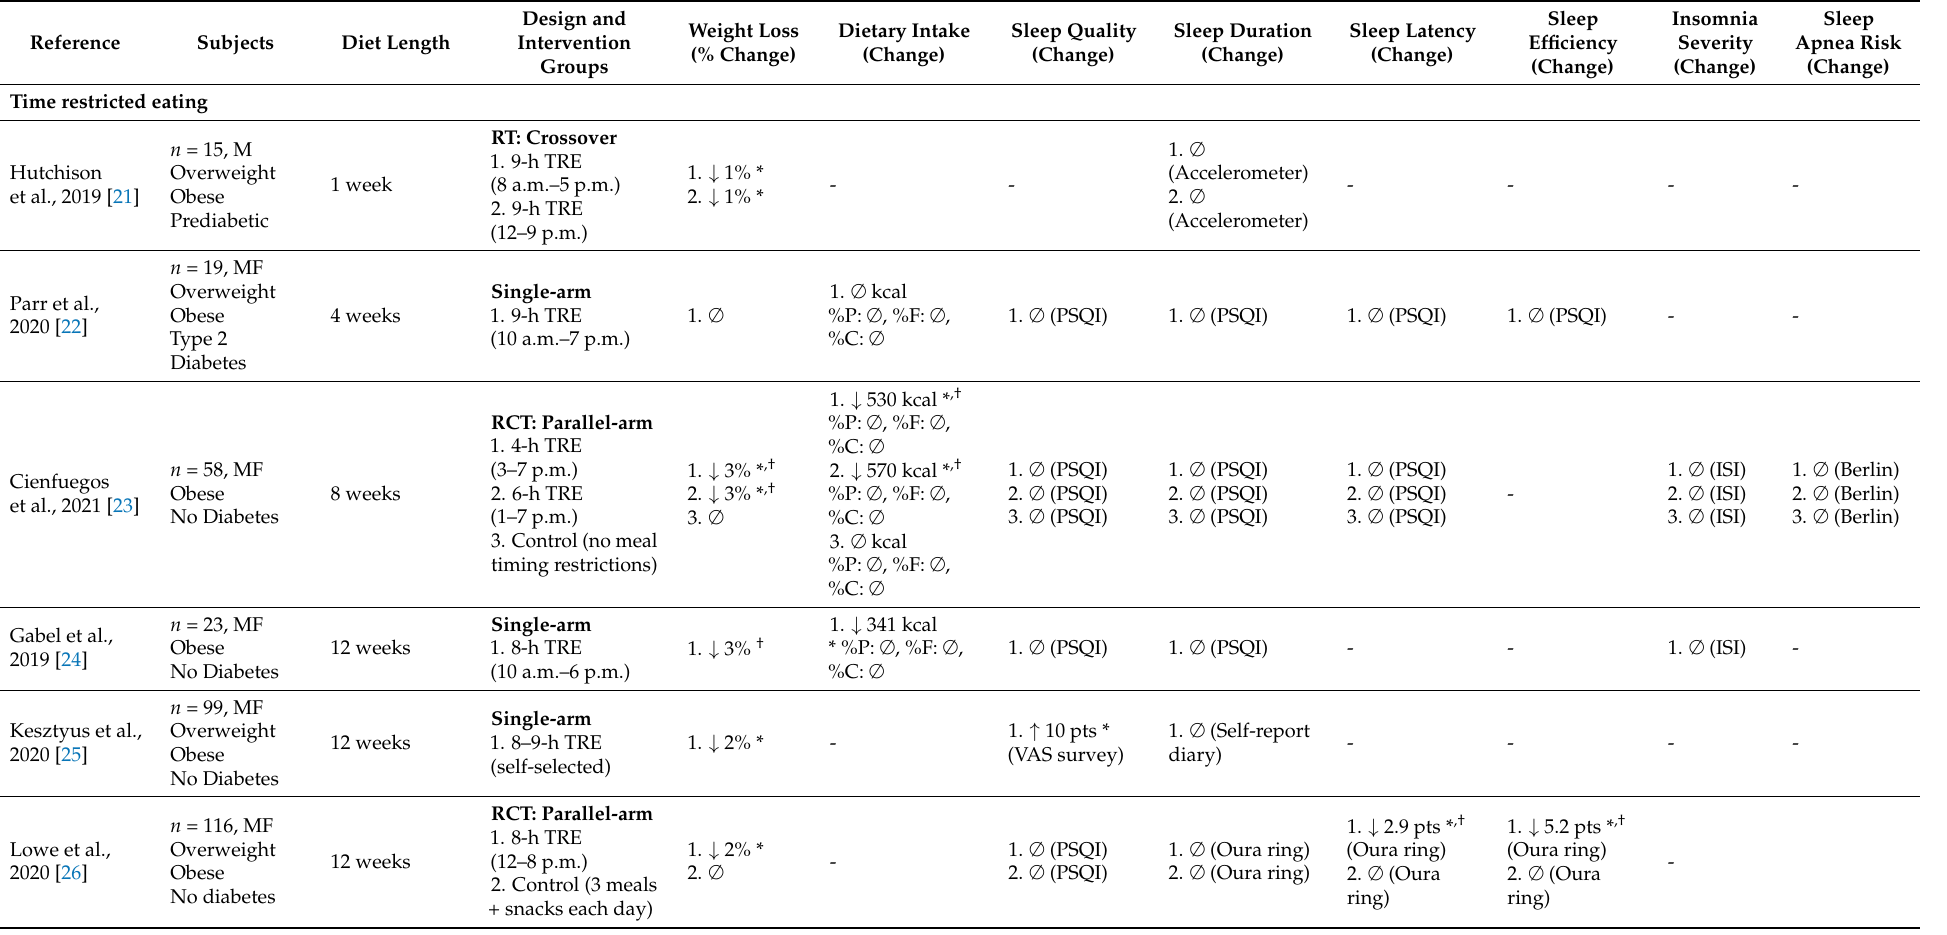
Table 1. Effect of intermittent fasting on sleep parameters in adults with overweight and